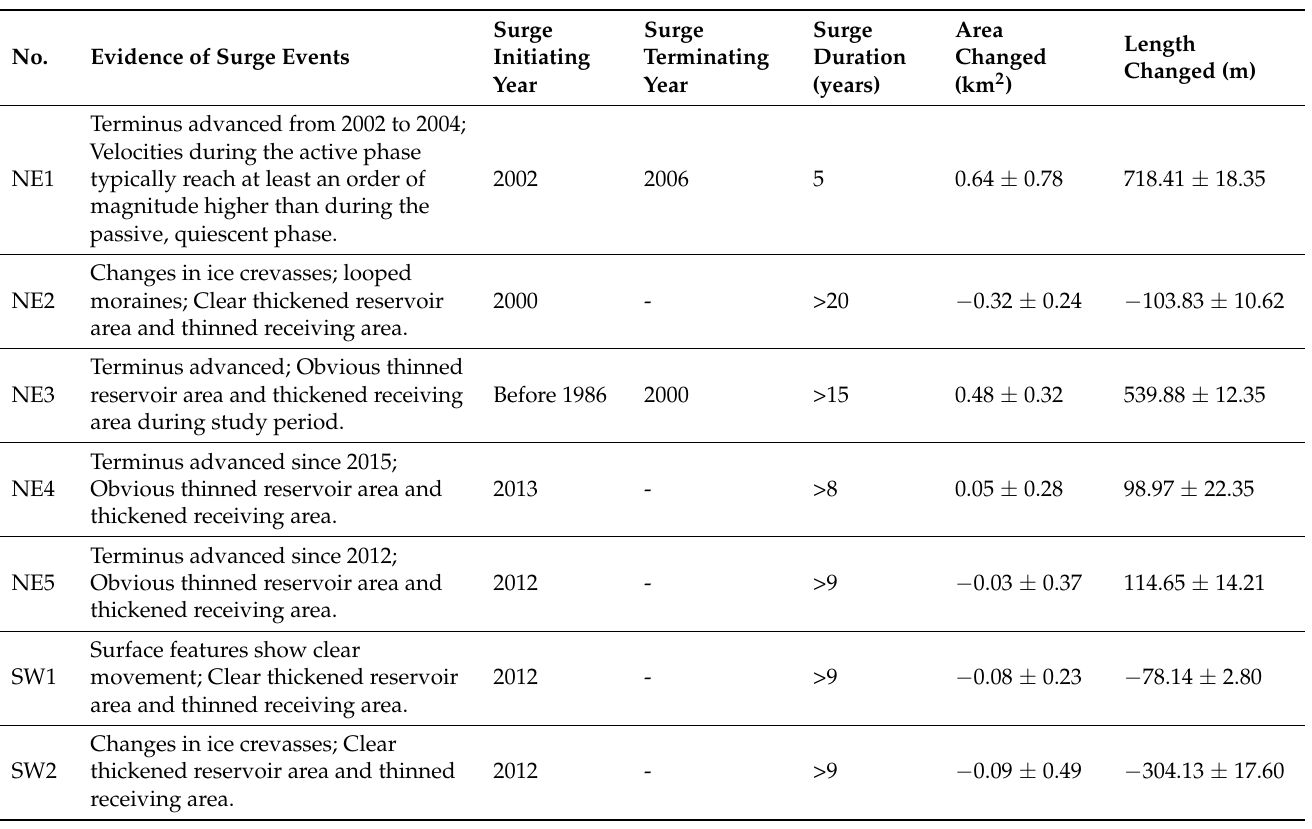
Table 4. Detailed information of each surge-type glacier in this study, including evidence of each surge event, their initiating and terminating year, their duration, their area changed, and their length changed in the active phase. The result was obtained from Landsat, ASTER, and Sentinel-2 images between 1973 and 2020.